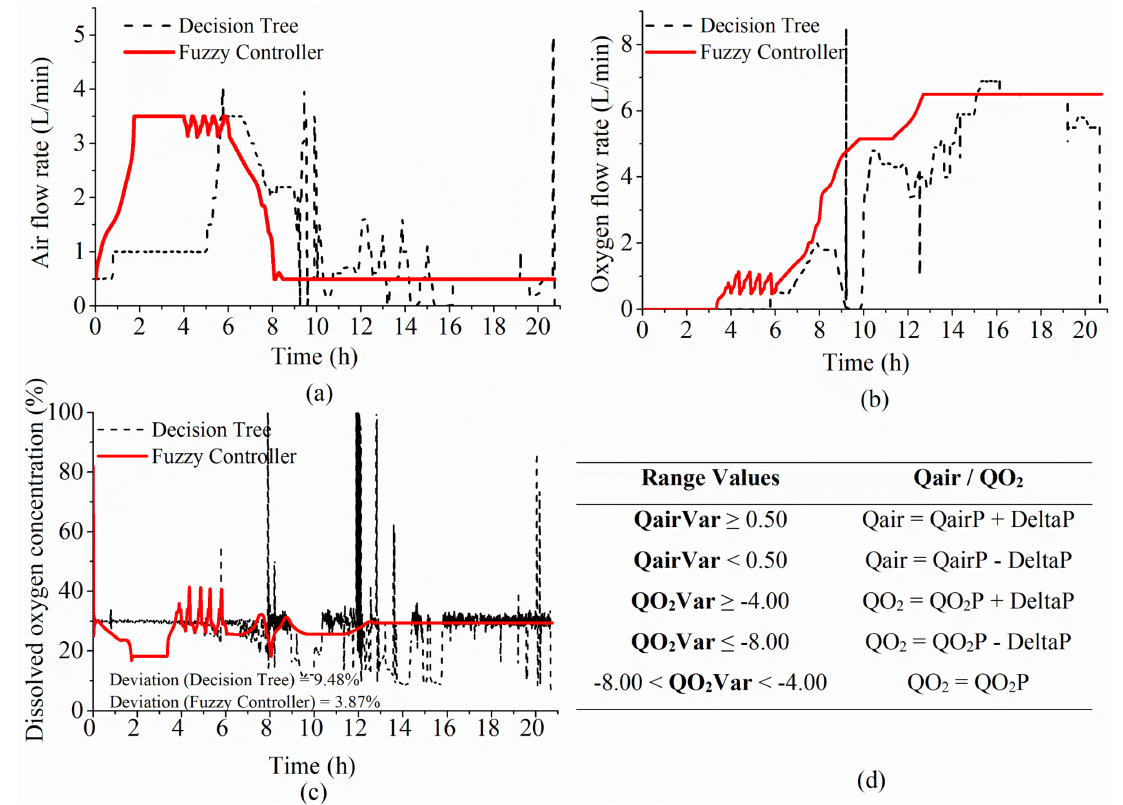
Figure 7. Robustness tests results for DOC fuzzy control using the simulator. The dashed line represents previously controlled cultivation data using the decision tree, whereas the solid line represents the simulated process, controlled by the fuzzy controller. Dynamics of air ( a ) and oxygen ( b ) flow rates comparing both controllers, DOC results during fuzzy control compared with the decision tree ( c ), and limits for comparing QairVar and QO 2 Var to appropriate range values ( d ) to analyze if maintaining, increasing, or decreasing the previous QairP and QO 2 P flow